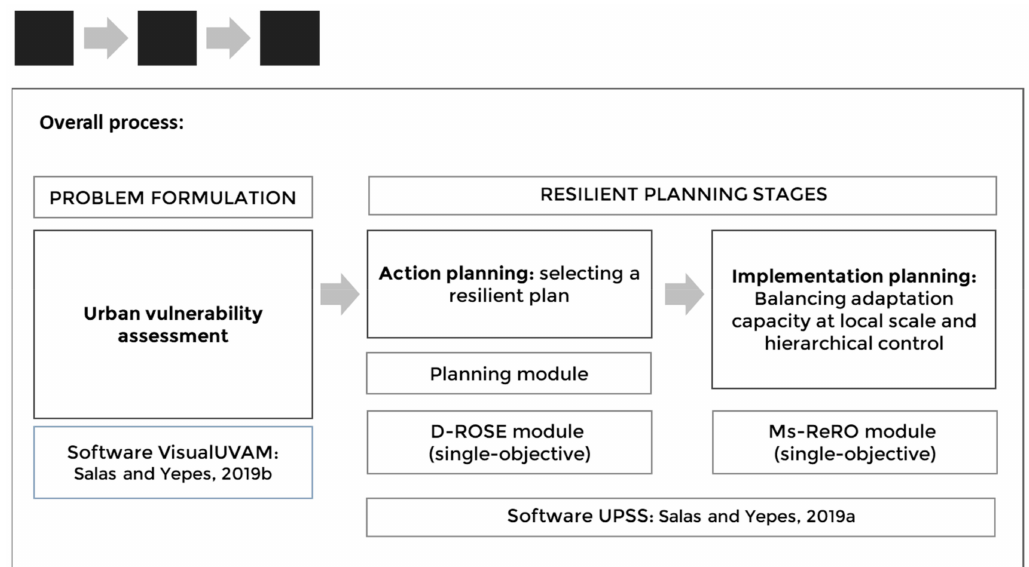
Figure 1. Overall process: vulnerability assessment and resilient